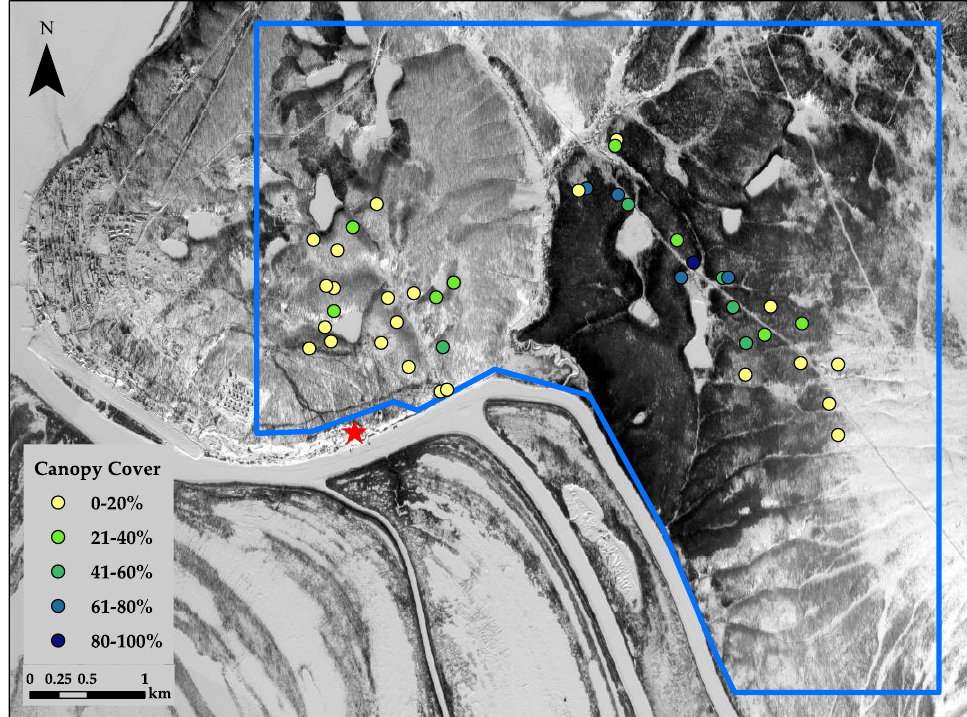
Figure 1. Map of the study area in northeastern Siberia. The blue polygon denotes the upland larch forested area used for analysis in this study. The red star denotes the location of the Northeast Science Station. Colored points indicate forest stand sample locations and associated canopy cover values. The background image is a panchromatic WorldView2 satellite image from 8 March 2015.